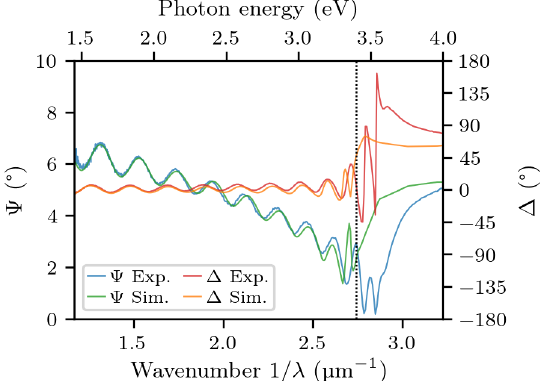
Figure 6. The ellipsometric parameters Ψ and ∆ of sample A , as a function of wavenumber, with the simulation superimposed. The vertical line marks the bandgap energy of undoped